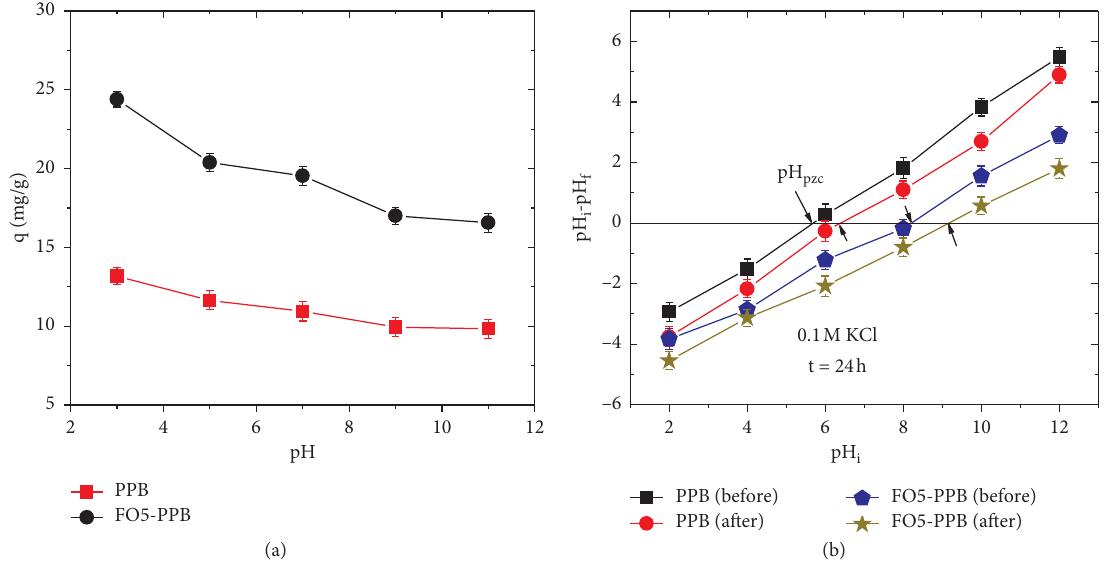
Figure 6: (a) The effects of pH on RR21 adsorption; (b) pH PZC of PPB and FO5-PPB before and after adsorption. Conditional parameters: RP21 initial concentration: 50mg/L; adsorbent dose: 2g/L; adsorption time: 90min; temperature: 25 ± 2 ° C.